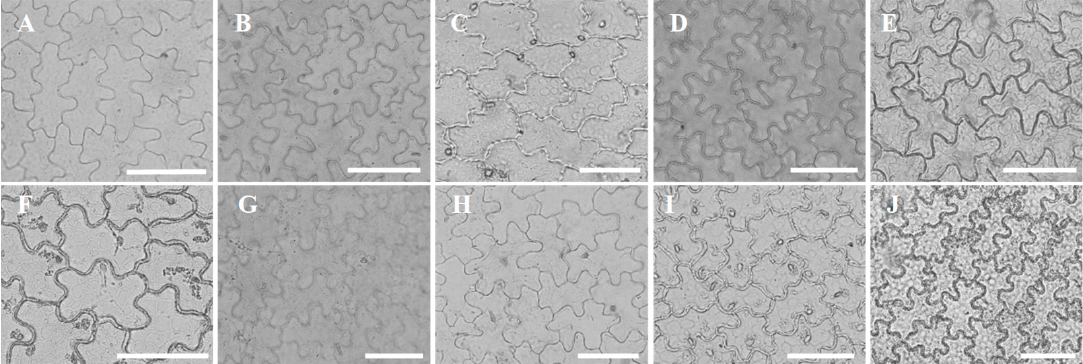
Figure 2. Characteristics of epidermal cells under light microscope in ten wild tree peonies, all adaxial. ( A ) P. qiui ; ( B ) P. decomposita ; ( C ) P. jishanensis ; ( D ) P. ostii ; ( E ) P. delavayi ; ( F ) P. lutea ; ( G ) P. potanini ; ( H ) P. rockii ; ( I ) P. ludlowii ; ( J ) P. cathayana . (bar = 50 μ m).